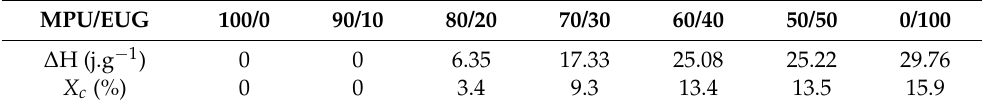
Figure 4. DSC and XRD curves of various MPU/EUG composites. ( a ) DSC curves; ( b ) XRD curves. Table 2. Crystallinity of various MPU/EUG